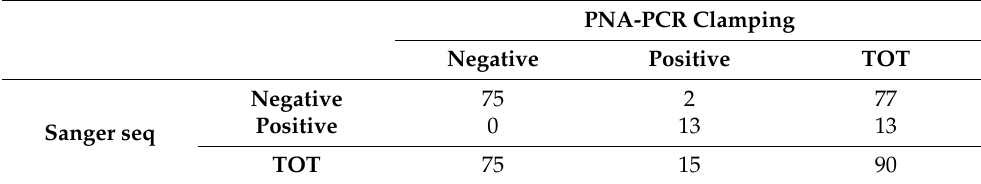
Table 1. PNA-PCR clamping and Sanger sequencing results.